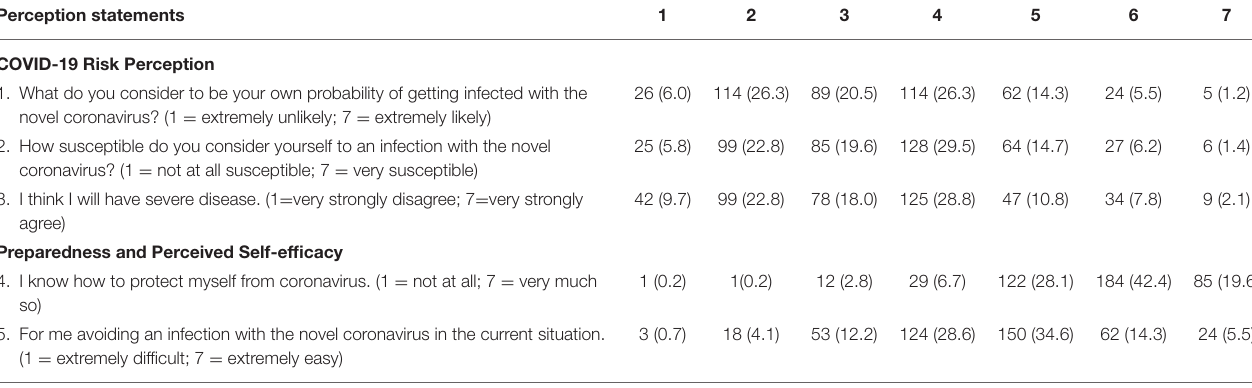
TABLE 4 | COVID-19 Risk Perception, and Perceived Preparedness & Self-efficacy ( n =